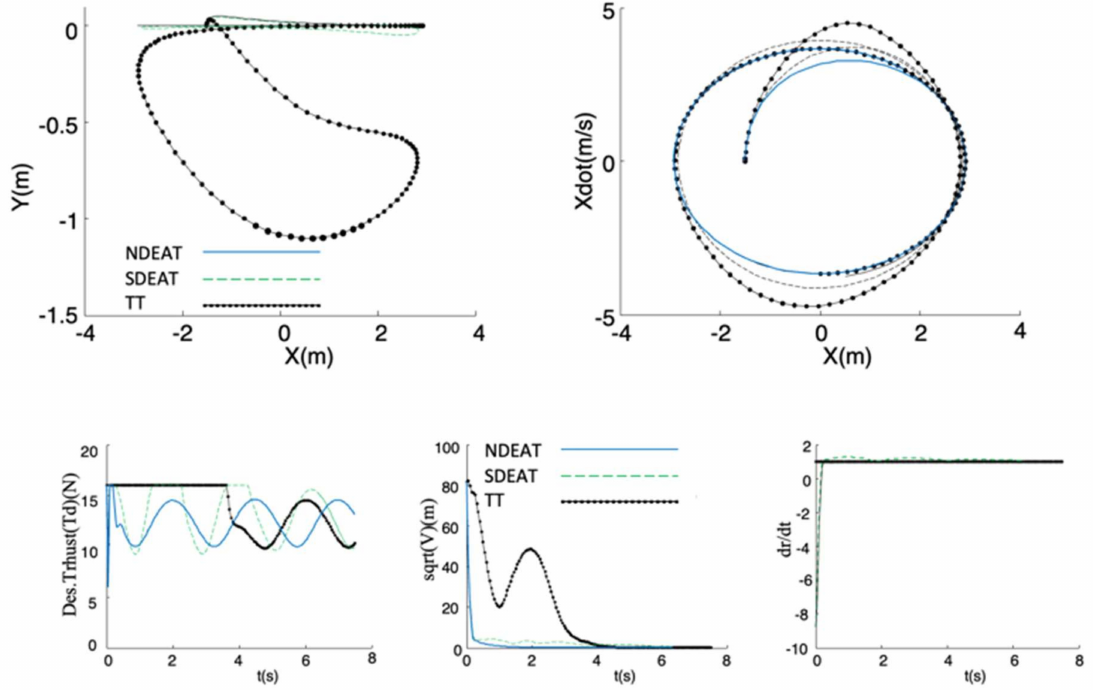
Figure 4. Comparison of NDEAT, SDEAT, and TT when the robot is delayed (desired path consists on a periodic horizontal motion x des (r) = A sin(w ref r) , y des (r) = constant ). Up : Left , Y/X trajectories; . X / X Bottom : Left , Desired Thrust T d (with saturation). Middle : Lyapunov Right : evolution of function versus time. Right : evolution of σ = dr / dt with respect to